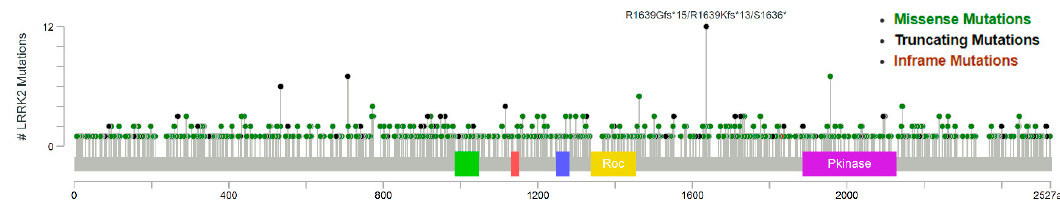
Figure 3. LRRK2 missense, truncating, and inframe mutations in the studies analyzed. A scattered mutational distribution is evident. The alterations are color-coded as shown in the legend above [48– 50].